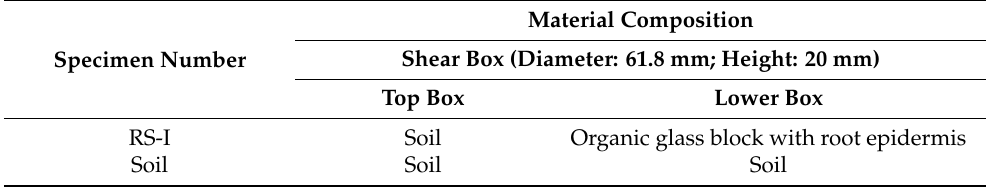
Figure 13. Preparation of root-permeated soil sample with δ of 45° (RAR0.21% as an example). Table 3. Sample number and material parameters of direct shear test with root-bearing soil. Specimen Number